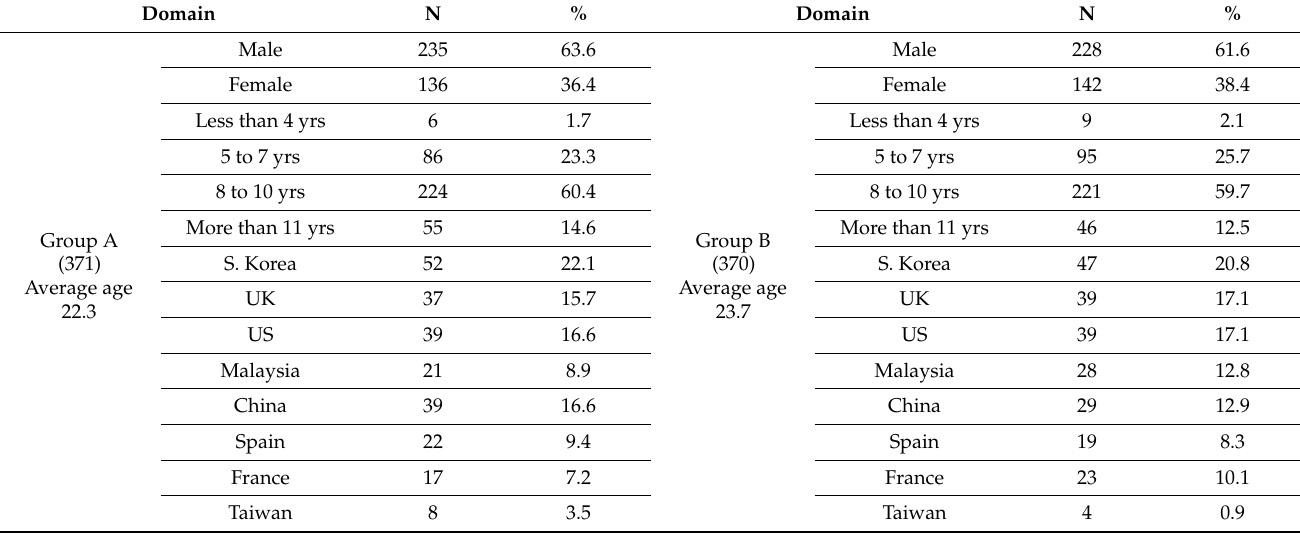
Table 2. General characteristics of survey